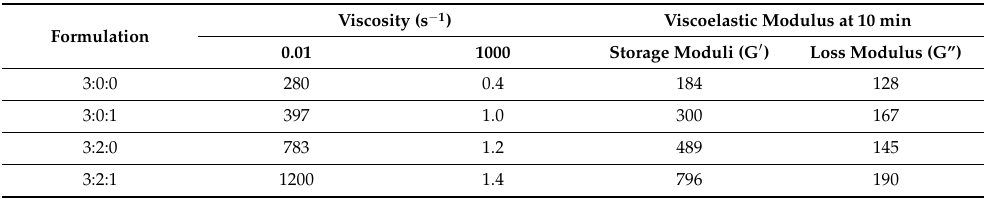
Table 2. Mean values of viscosity at a low (0.01 s − 1 ) and high shear rate (1000 s − 1 ) and mean values of viscoelastic modulus obtained at 37 ◦ C after 10 min.